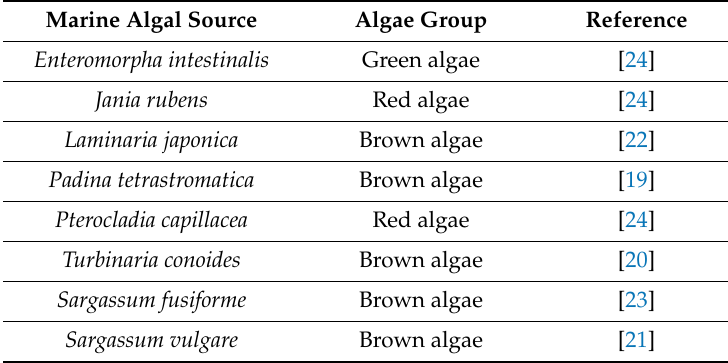
Table 2. Marine algae source with antiangiogenic activity attributed to SPs.